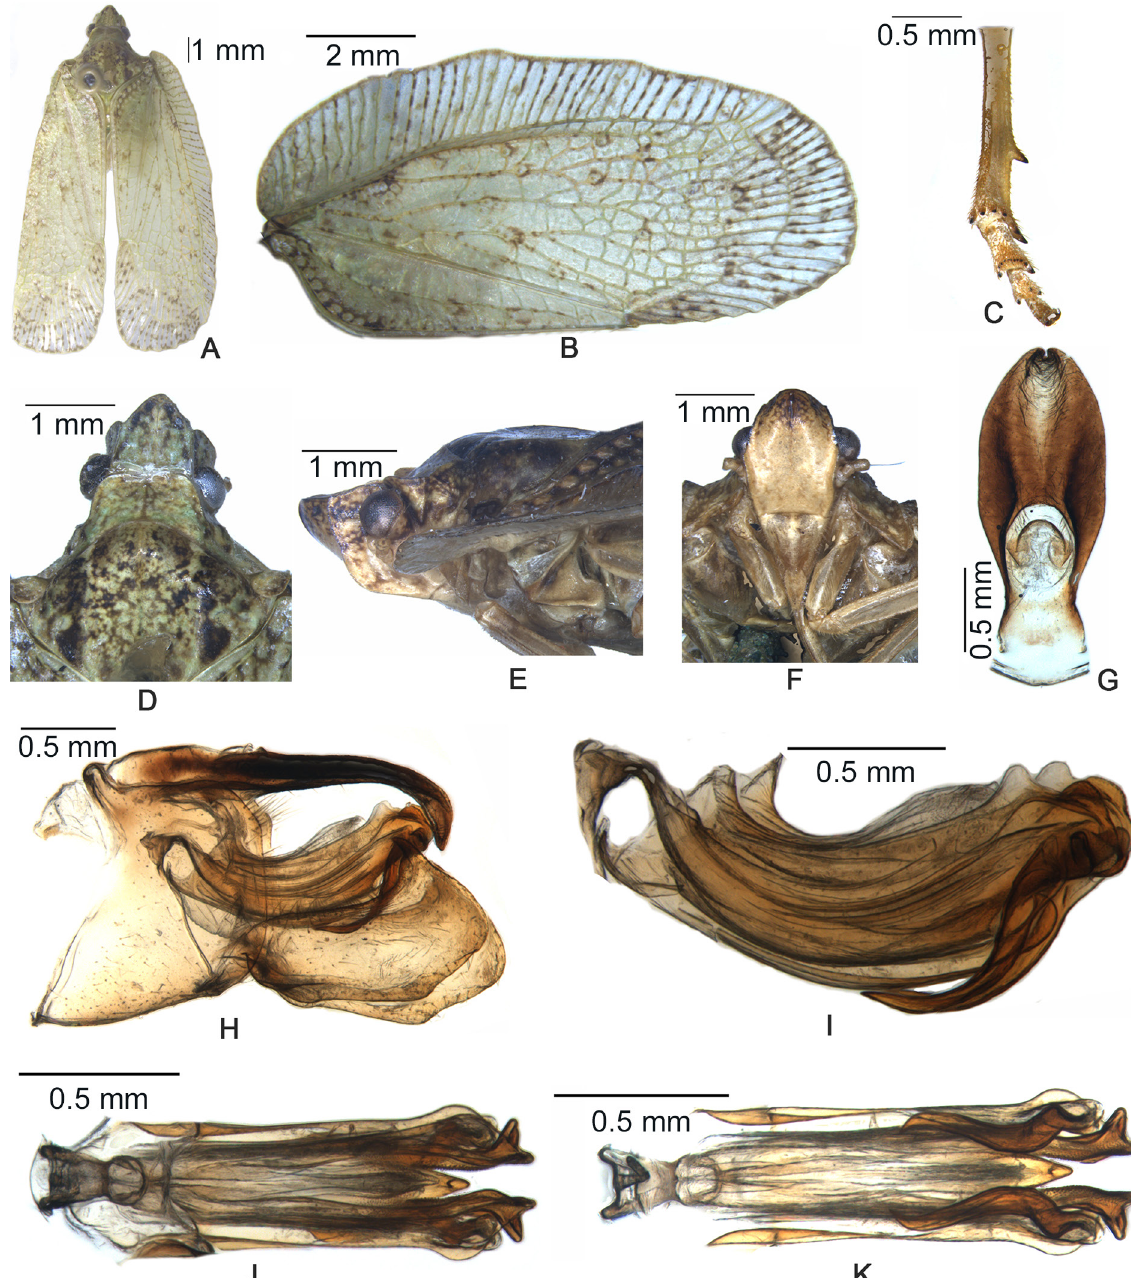
Fig. 3. Atracis patefacta sp. nov. A . Habitus, dorsal view. B . Tegmen. C . Hind leg apex. D . Head and thorax, dorsal view. E . Head and thorax, left lateral view. F . Face. G . Male anal tube, dorsal view. H . Male genitalia, right lateral view. I . Phallic complex, right lateral view. J . Phallic complex, dorsal view. K . Phallic complex, ventral